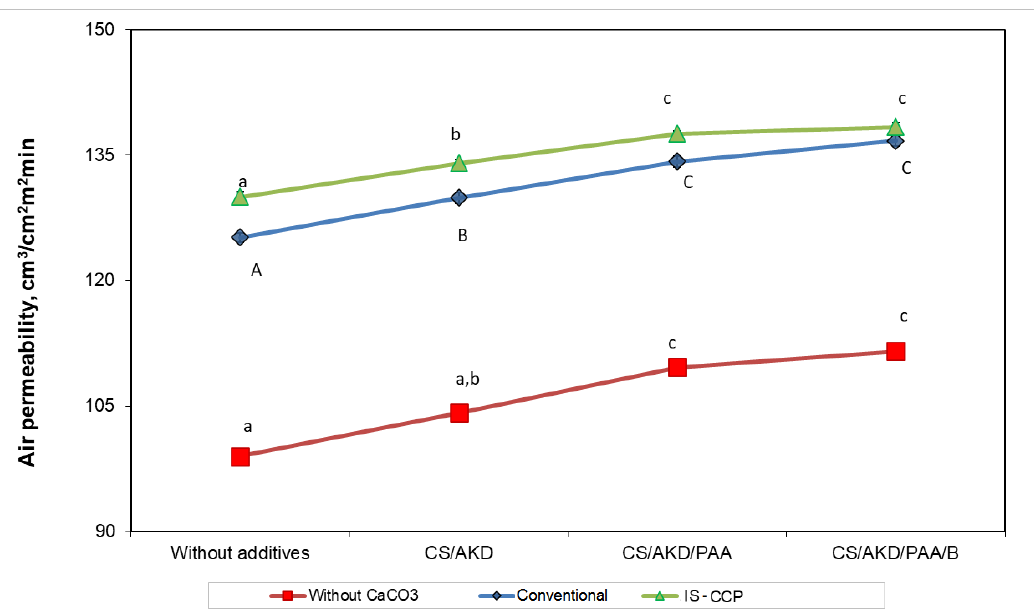
Figure 6. Air permeability for different additive systems in relation to paper composition (different letters within the same method—small letters for conventional and capitals for IS-CCP designate statistical difference, p < 0.05).